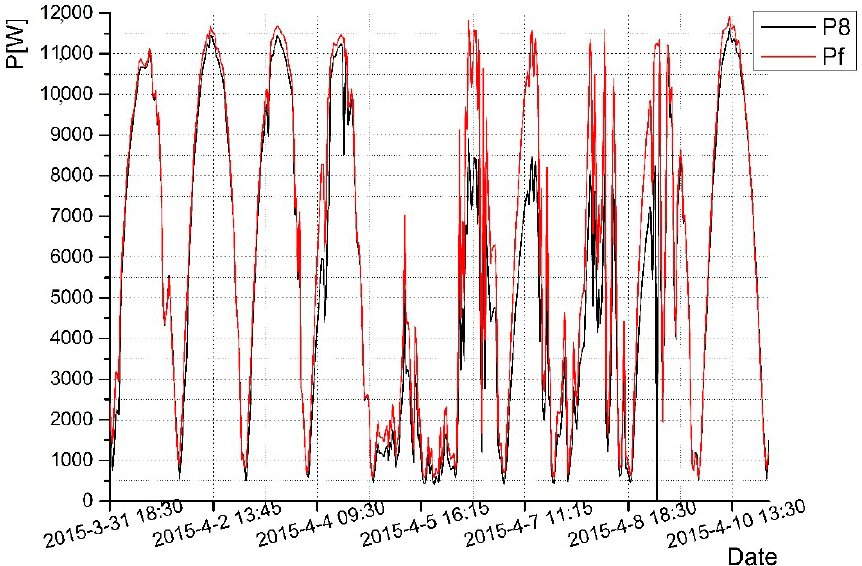
Figure 4. Actual output of inverter 8 (PVS1), compared with the ANN simulated output from n1, for the period 1 April 2015 to 11 April 2015 (abnormal operation due to faulty DC fuse observed from 5.4 to 9.4).